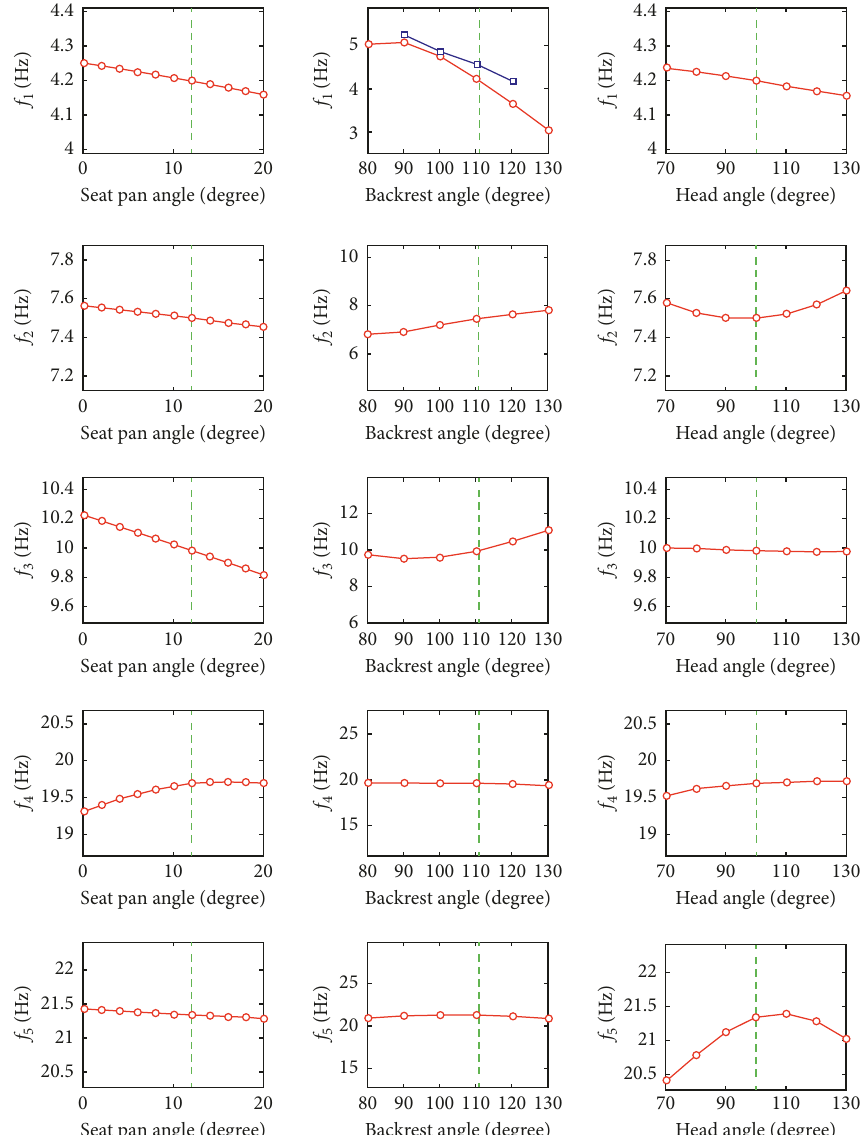
Figure 5: Natural frequencies of the five-degree-of-freedom linear model with respect to the seat pan, backrest, and head angle (dotted vertical green line: baseline angle; blue line in the graph in the second column of the first row: experimental results [35]; the top through the bottom rows represent the first through the fifth modes,